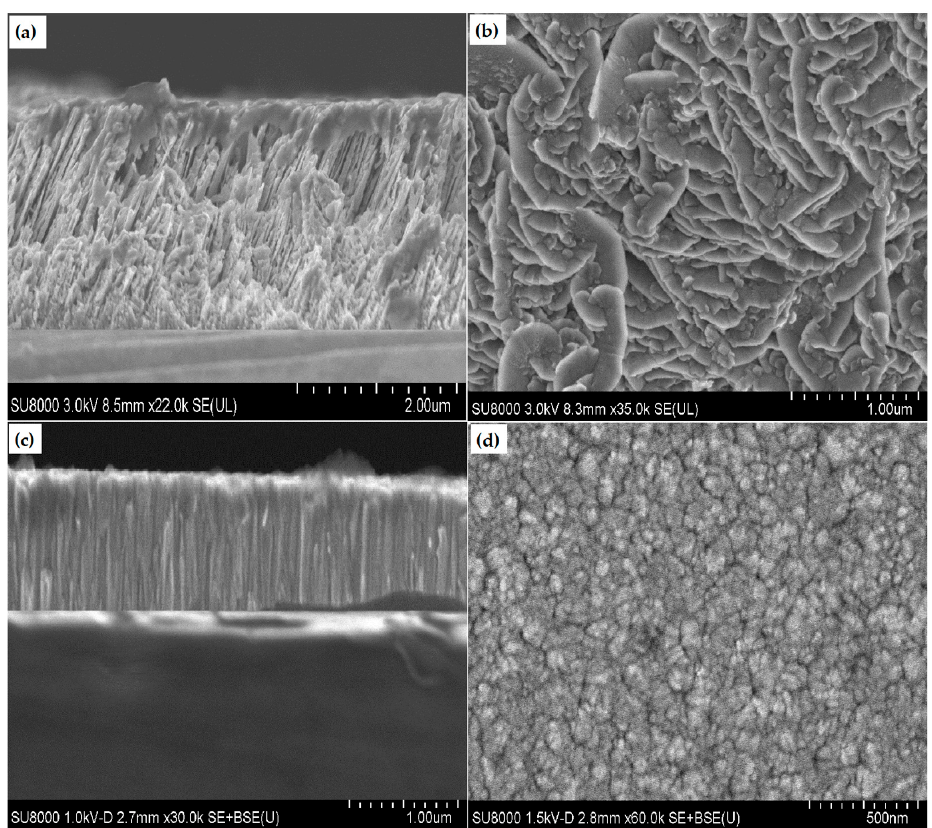
Figure 2. SEM cross-section and surface micrographs of chromium oxide coatings deposited at 300 °C ( a , b ) and room temperature ( c , d ), respectively.